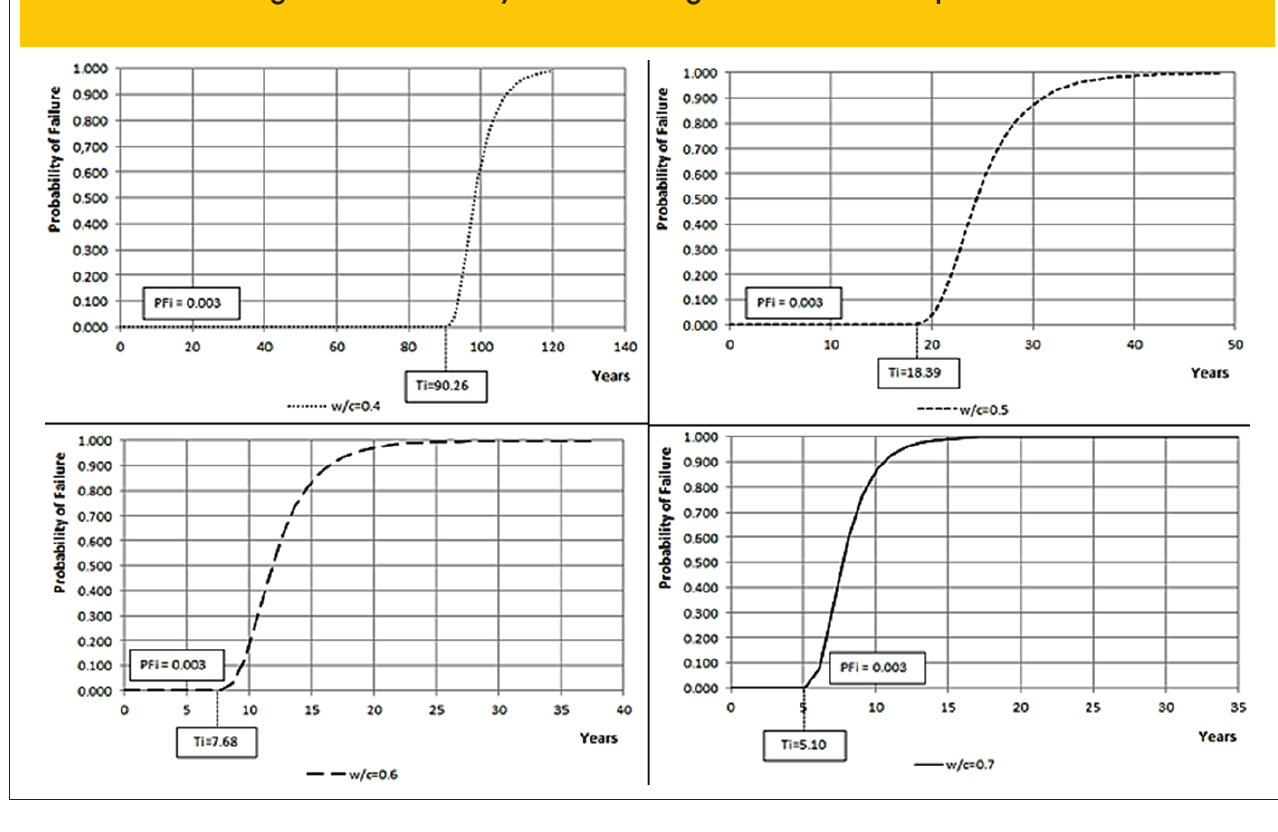
Figure 18 – Probability of failure along time for CA III and β x=0.259